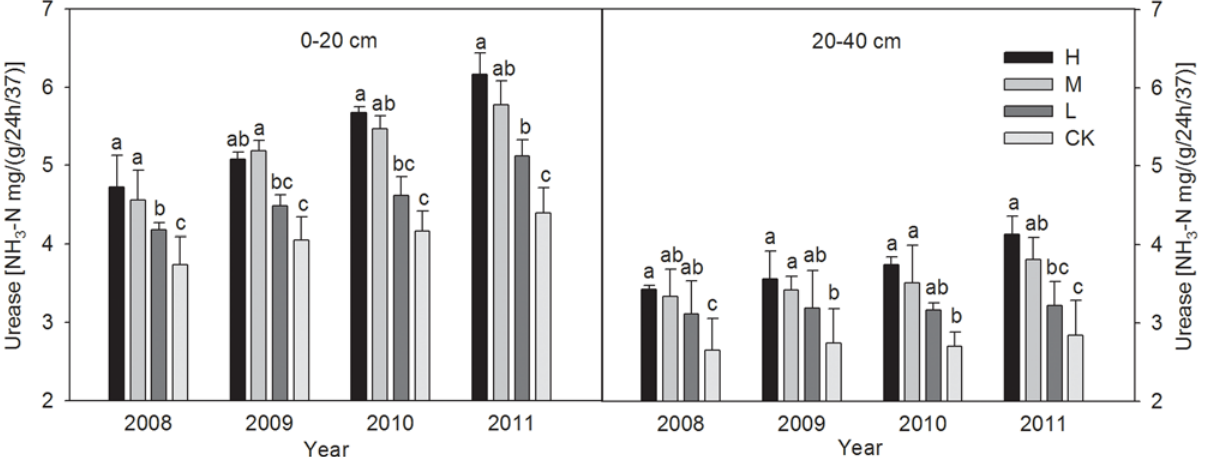
Fig 1. The changes of Urease activities in 0 – 20 and 20 – 40 cm soil layers under different wheat straw incorporation treatments. Note: CK, no straw incorporation; L, incorporation of straw at a low rate of 3 000 kg hm -2 wheat straw; M, incorporation of straw at a medium rate of 6 000 kg hm -2 wheat straw; H, incorporation of straw at a high rate of 9 000 kg hm -2 wheat straw. Bars with different lowercase letters indicate significant differences ( P < 0.05).